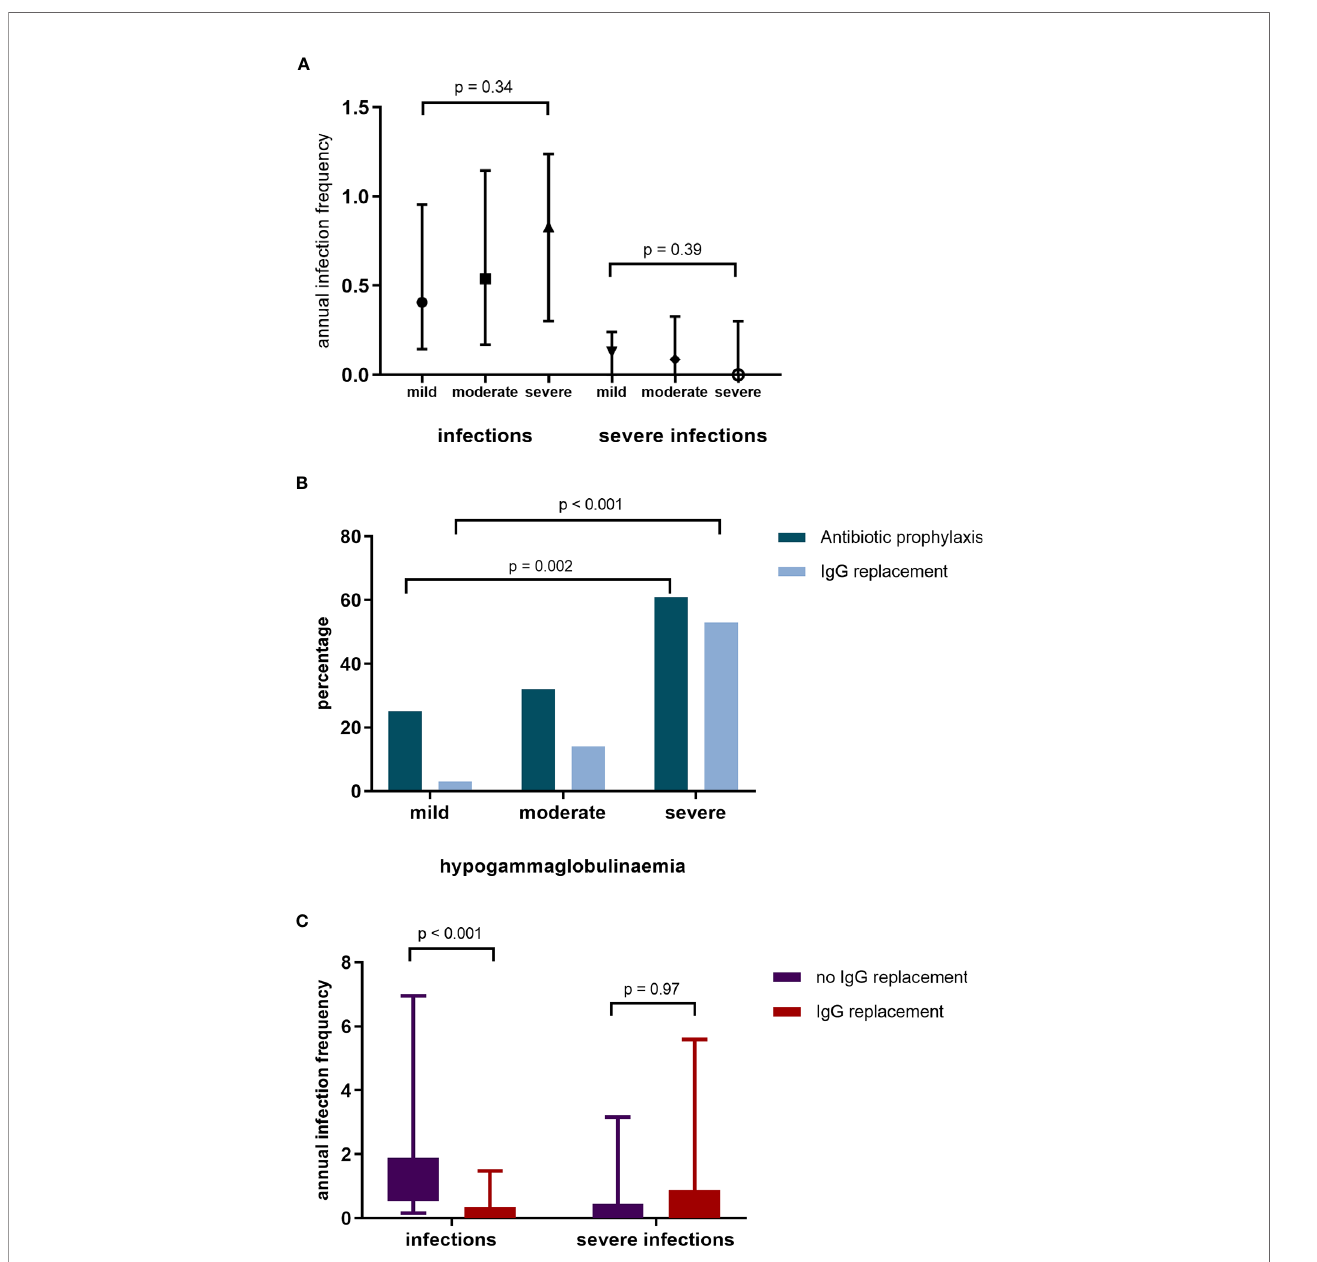
FIGURE 3 | (A) Annual infection and severe infection rate by IgG subgroup. (B) Commencement of antibiotic (Abx) prophylaxis and IgG replacement by IgG group. (C) Infection and severe infection rates in patients without IgG replacement and during IgG